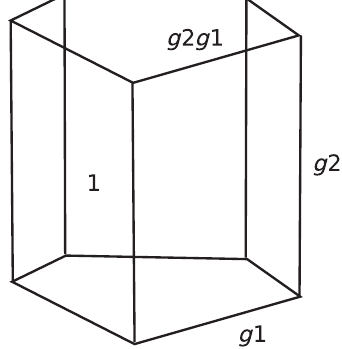
FIG. 16. A prism M × ½ 0 ; 1 (cid:3) mapping to BG means assigning G labels also to the interior edges. These correspond to the vertices of M , so we can think of them as a function g ∶ M 0 → G , where M 0 is the set of vertices of M . Then, the conservation law on the internal faces of the prism forces a constraint between corre- sponding edge labels in each M . The constraint is that the top labels are the gauge transformation of the bottom labels by g . The direction is fixed by an orientation of the internal prism edges. If we reverse all of them, it takes g ↦ g − 1 (and locally as